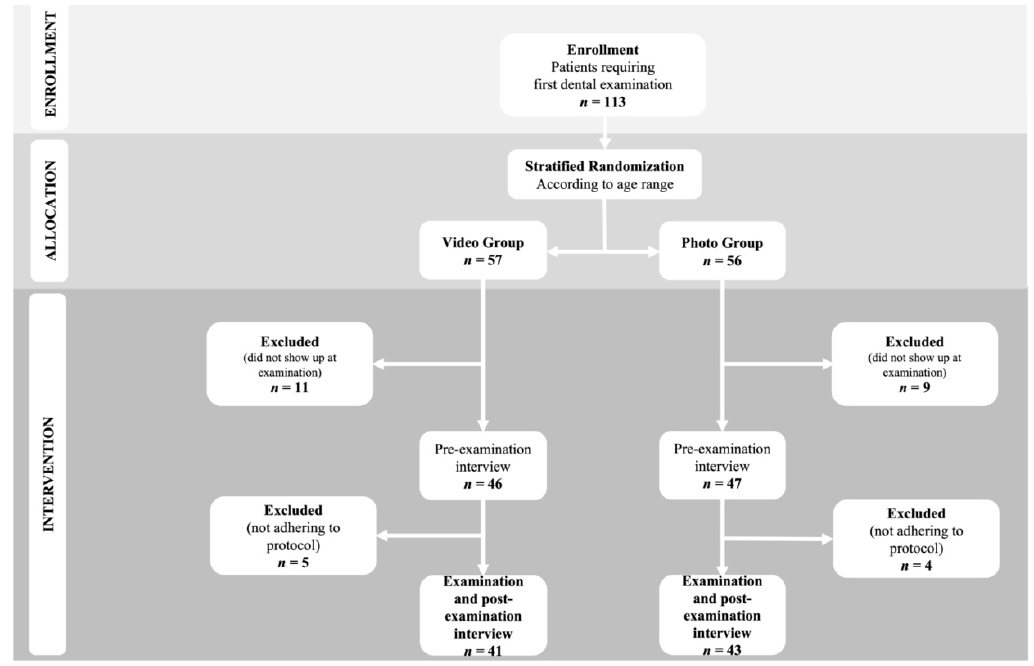
Figure 1. Consort flow diagram of the study.